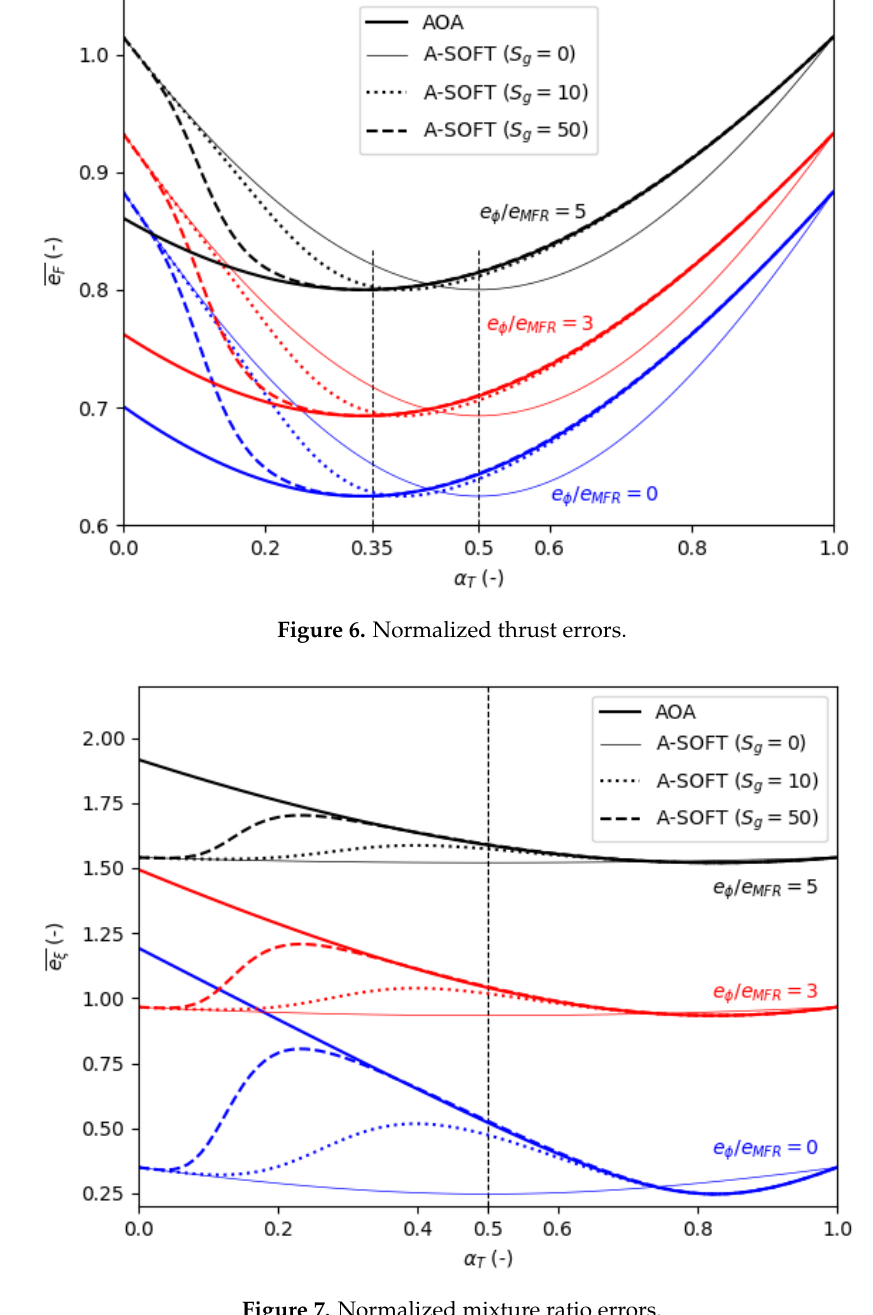
Figure 7. Normalized mixture ratio